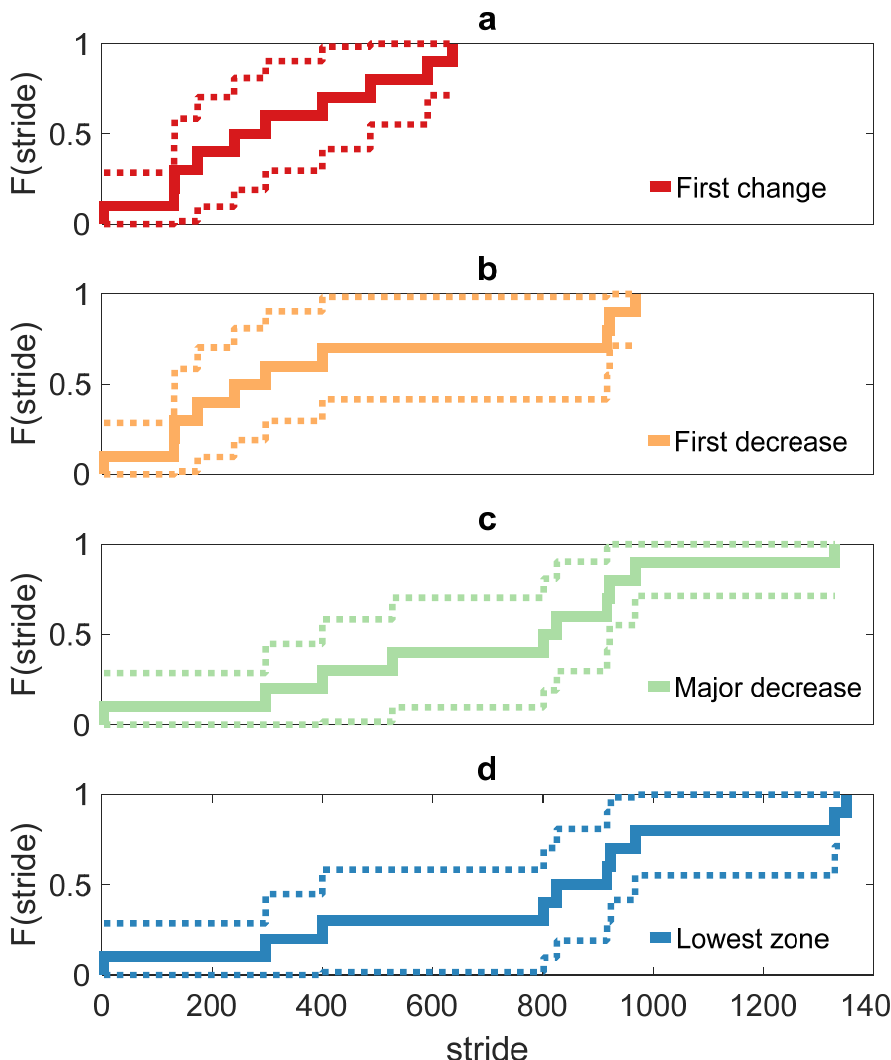
Figure 5. The cumulative distribution function describing ( a ) the first change in axial peak tibial acceleration, ( b ) the first reduction, ( c ) the major change, and ( d ) the zone of the lowest axial peak tibial acceleration in the biofeedback condition. In each panel, the horizontal axis shows the number of the gait cycles (strides) and the vertical axis shows the cumulative probability (F(stride)) between zero and one. The dashed lines indicate the Greenwood confidence interval.